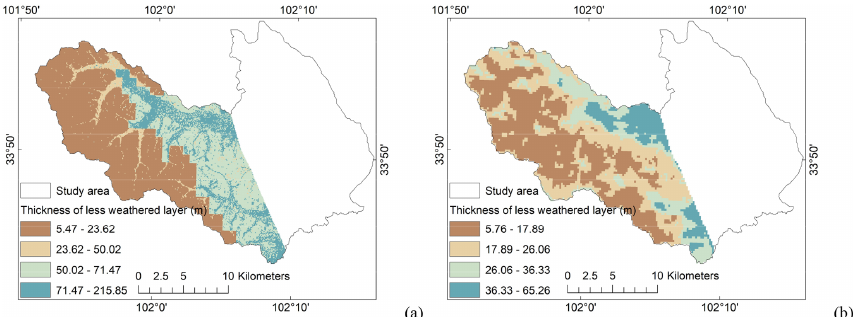
Figure 8. The estimated thickness of the less weathered layer in the west: (a) based on the ensemble model estimated depth to bedrock from Yan et al. (2020), (b) based on the depth to bedrock from Shangguan et al.